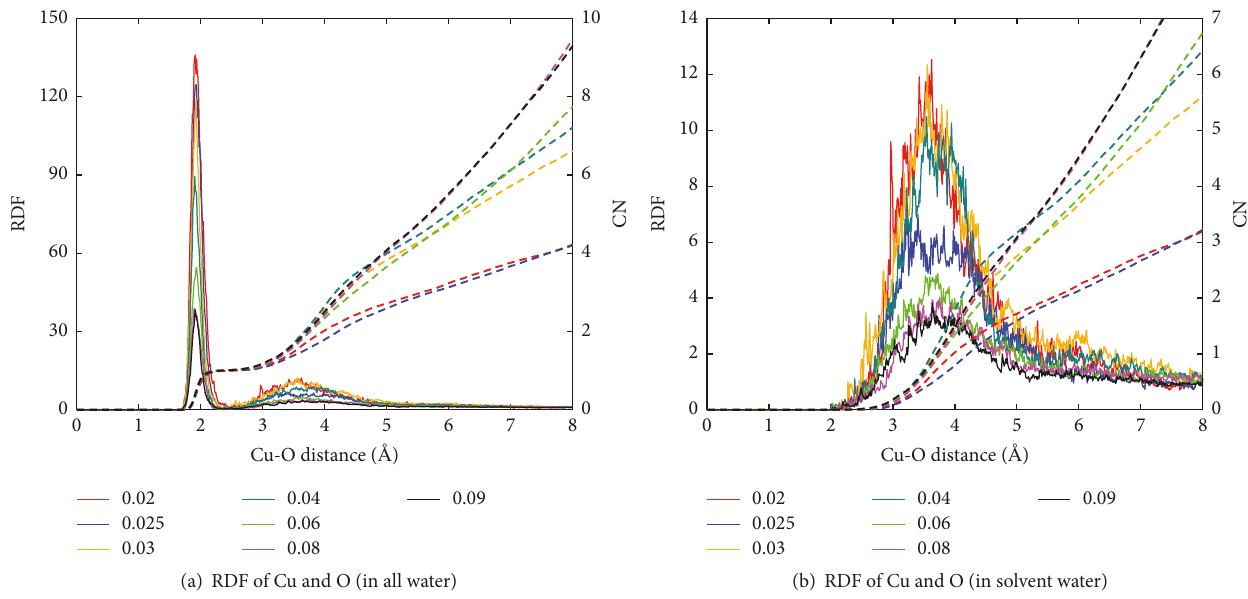
Figure2:TheCu-Oradialdistributionfunction(RDF,solidlines,leftaxes)andthecoordinationnumber(CN,dashedlines,rightaxes)versus the Cu-O distance. (a) The RDF of Cu with all O atoms in the simulation. (b) The RDF of Cu with O atoms in the solvent water (excluding the water molecule in the [CuCl(H 2 O)] clusters, second-shell hydration).